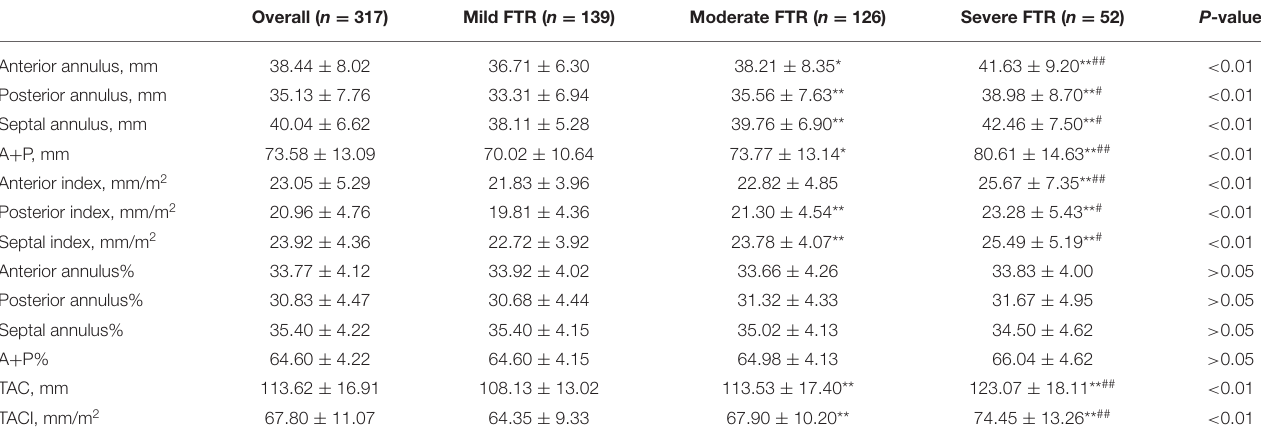
TABLE 2 | Tricuspid annulus obtained by intraoperative measurement.